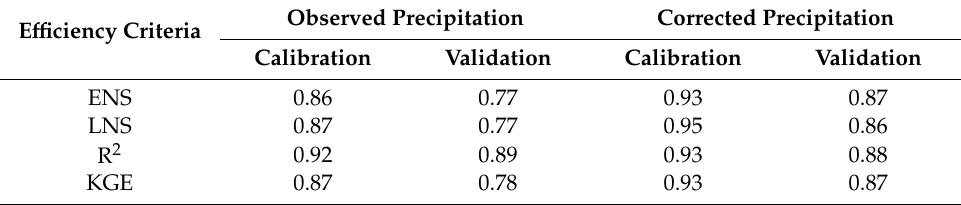
Figure 6. Observed and simulated discharge during the modeling period: ( a ) boxplot of average monthly observed and simulated values; ( b ) scatter plot of daily observed and simulated values. Table 5. E ffi ciency criteria derived from a comparison of simulated daily discharge values with observed values using observed and corrected